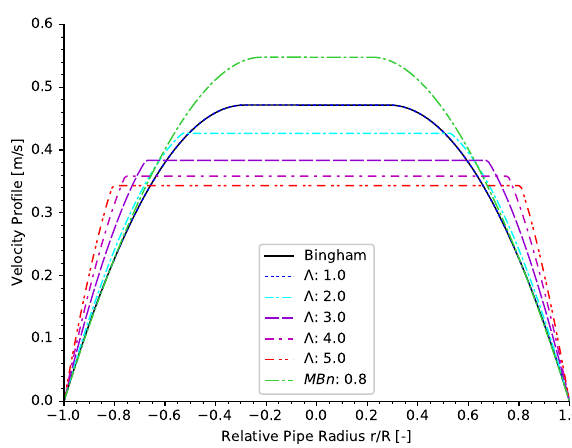
Figure 5: The velocity profile for various thixotropy factors Λ show that thixotropy can have a significant effect on a smooth transition from plug flow to shear flow. Higher thixotropy levels cause higher plug radii and in return lower plug velocities, however higher shear rates or velocity development near the pipe wall. ( ̂︀ Q = 0.55 with R = 52.65 mm )